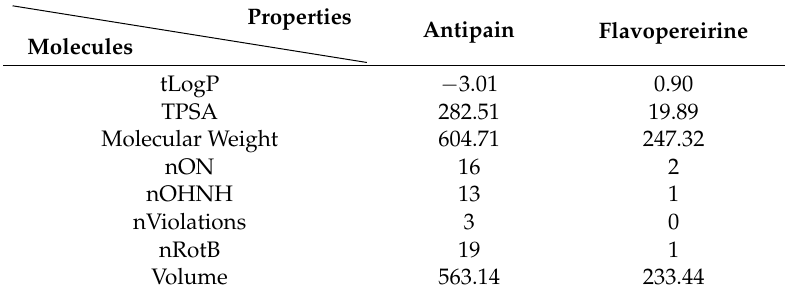
Table 4. Theoretical properties calculated from Molinspiration website of all tested molecules.